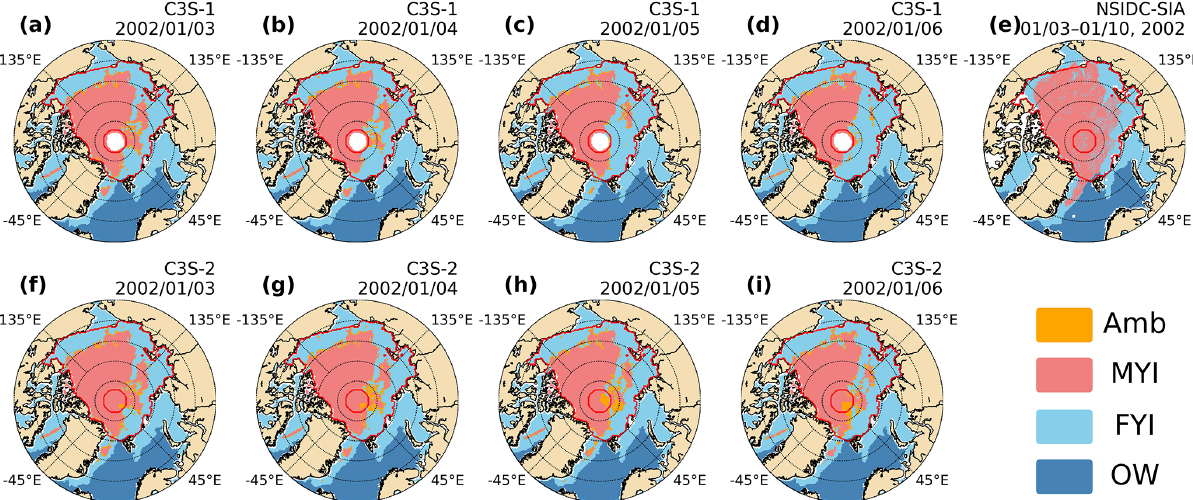
The Cryosphere, 17, 279–308,